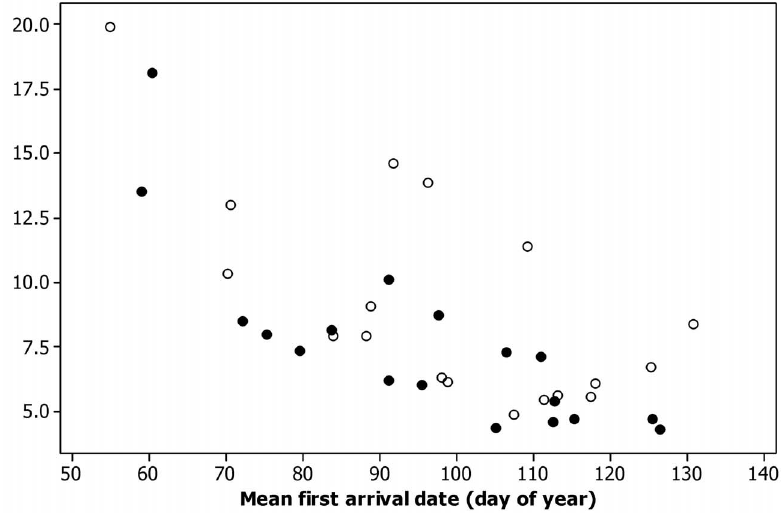
Figure 1. The relationship between standard deviation (SD) of first arrival dates and mean first arrival date (shown as day of the year, 1= Jan 1 etc.) for 18 species recorded at rural sites (solid symbols) and urban sites (open symbols) in Western Poland.